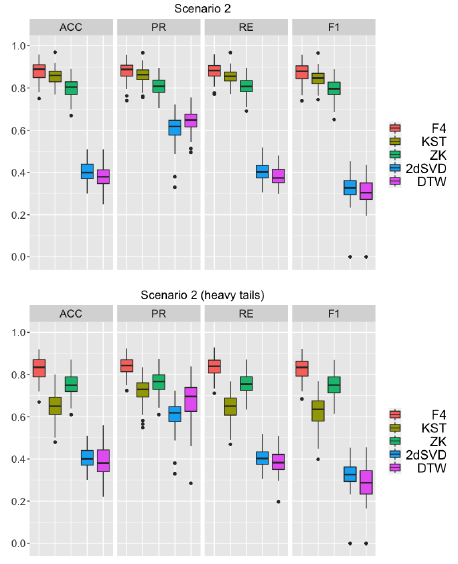
Figure 3. Boxplots of accuracy, precision, recall and F1-score based on 100 trials of the simulation procedure for Scenario 2 (top panel) and for Scenario 2 with heavy tails (bottom